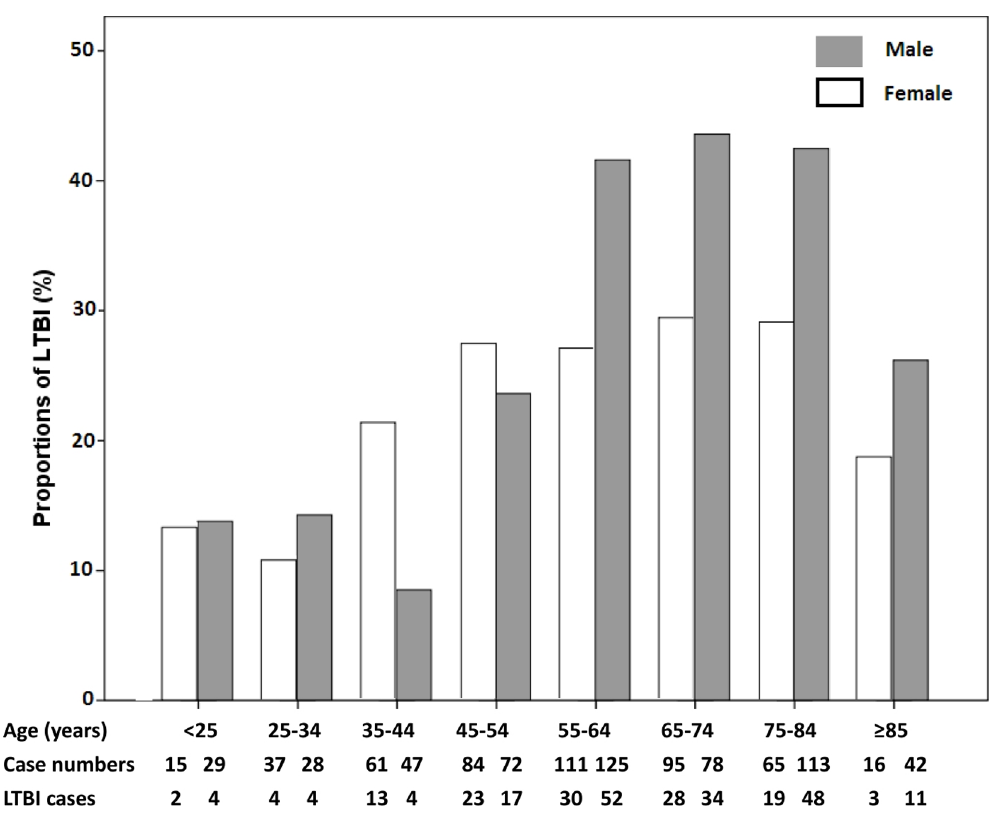
Figure 2. Proportions of latent TB infection between sexes in various age groups.